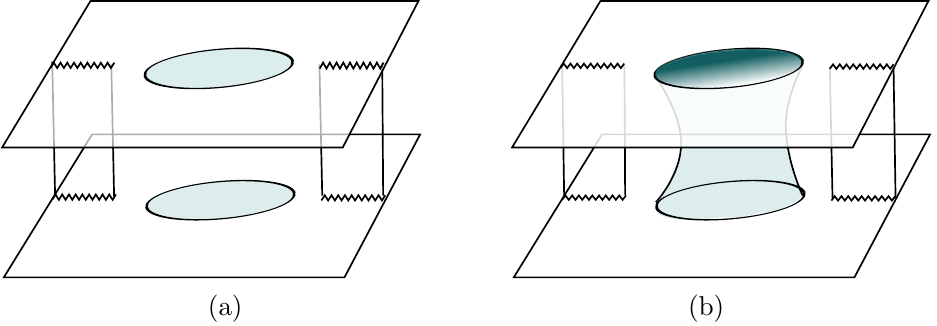
Figure 6 . Two di(cid:11)erent saddlepoint contributions to the two-replica path integral in the presence of gravity in the shaded region. On the left the replicas are sewn together along the branch points, outside of the shaded region, as we would do in an ordinary quantum (cid:12)eld theory calculation. These will give the standard QFT answer, as computed by Hawking, which can lead to a paradox. On the right we have a saddle where gravity dynamically glues together the shaded regions. This is the replica wormhole. In the examples considered in this paper, this saddle dominates in the relevant kinematics, leading to a Page curve consistent with